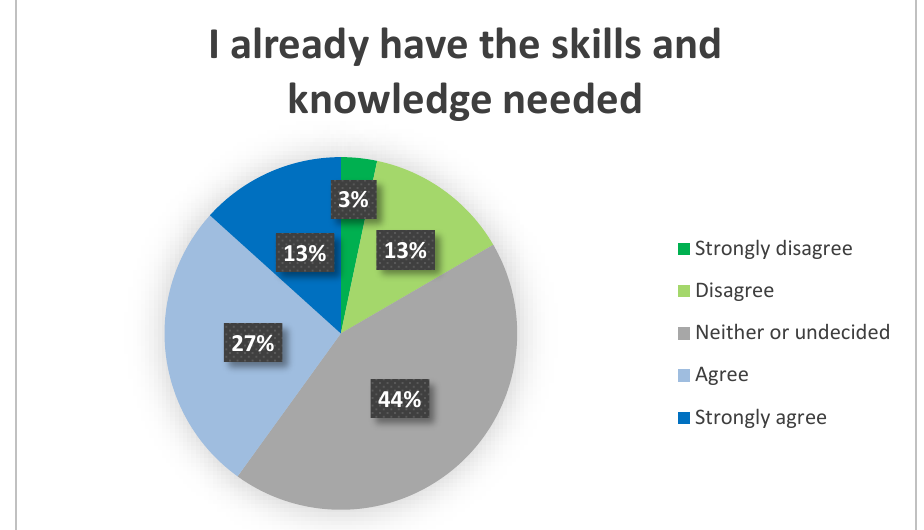
Figure 4. Industry agreement with the statement “I already have the knowledge and skills needed to use tissue culture trees”.